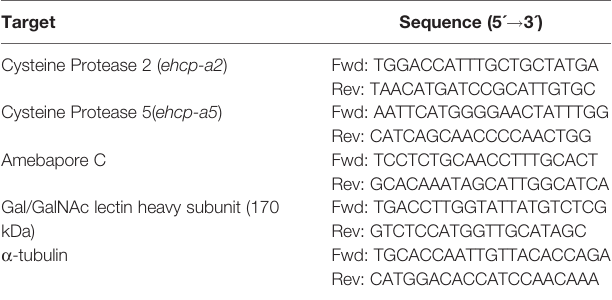
TABLE 1 | Entamoeba histolytica gene-targeted primers used in this